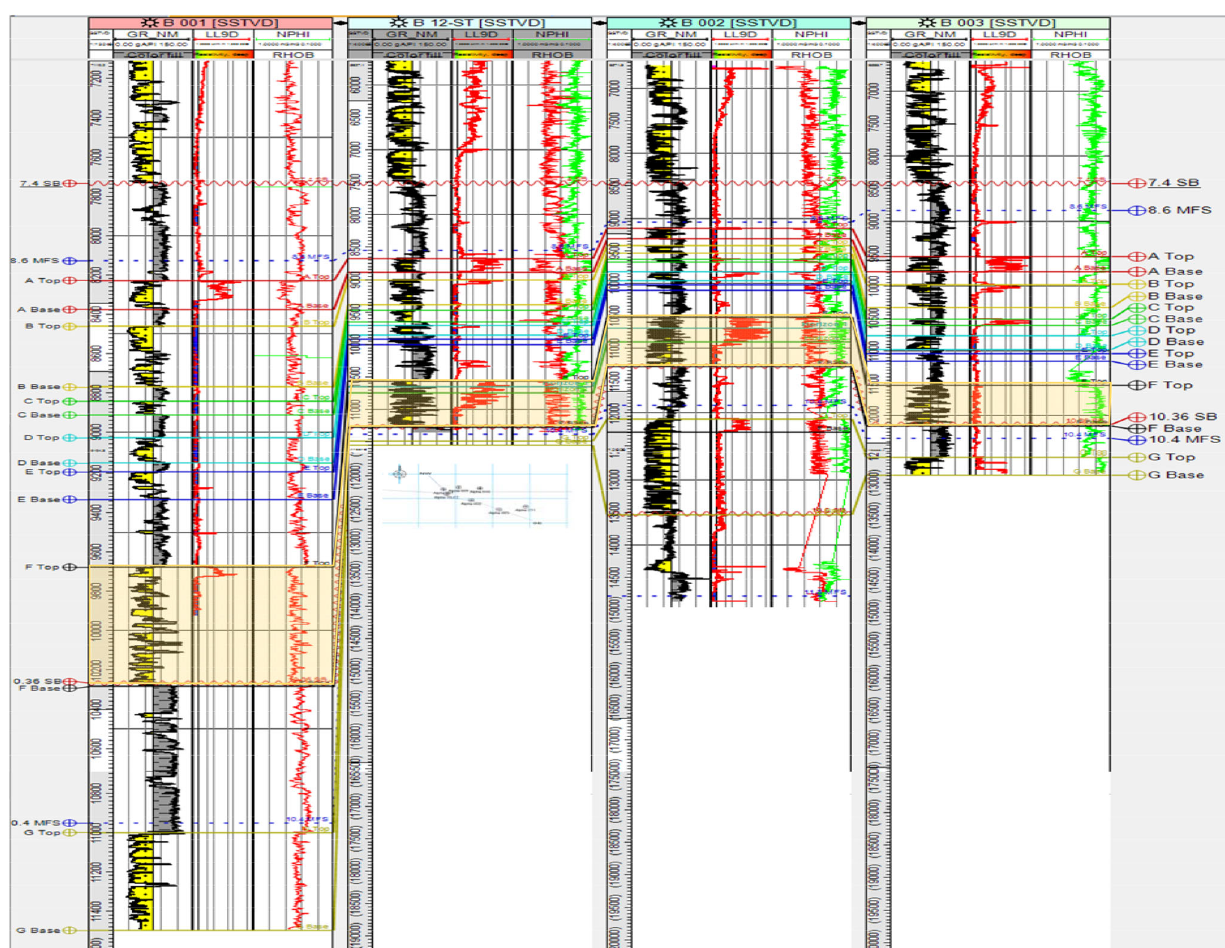
Fig. 5 Reservoir correlations in Bruks Field along the dip